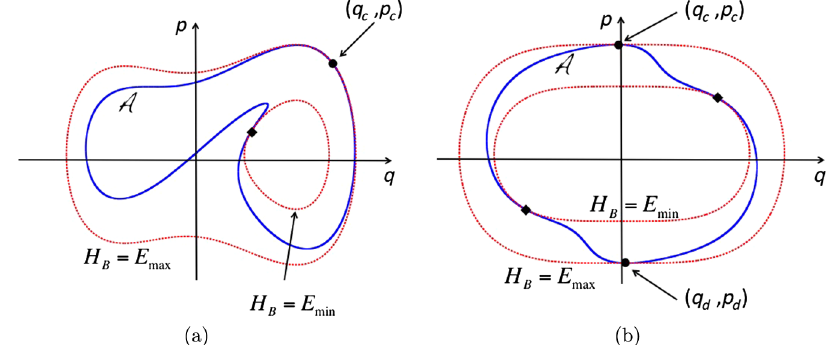
. Diamonds and dots B